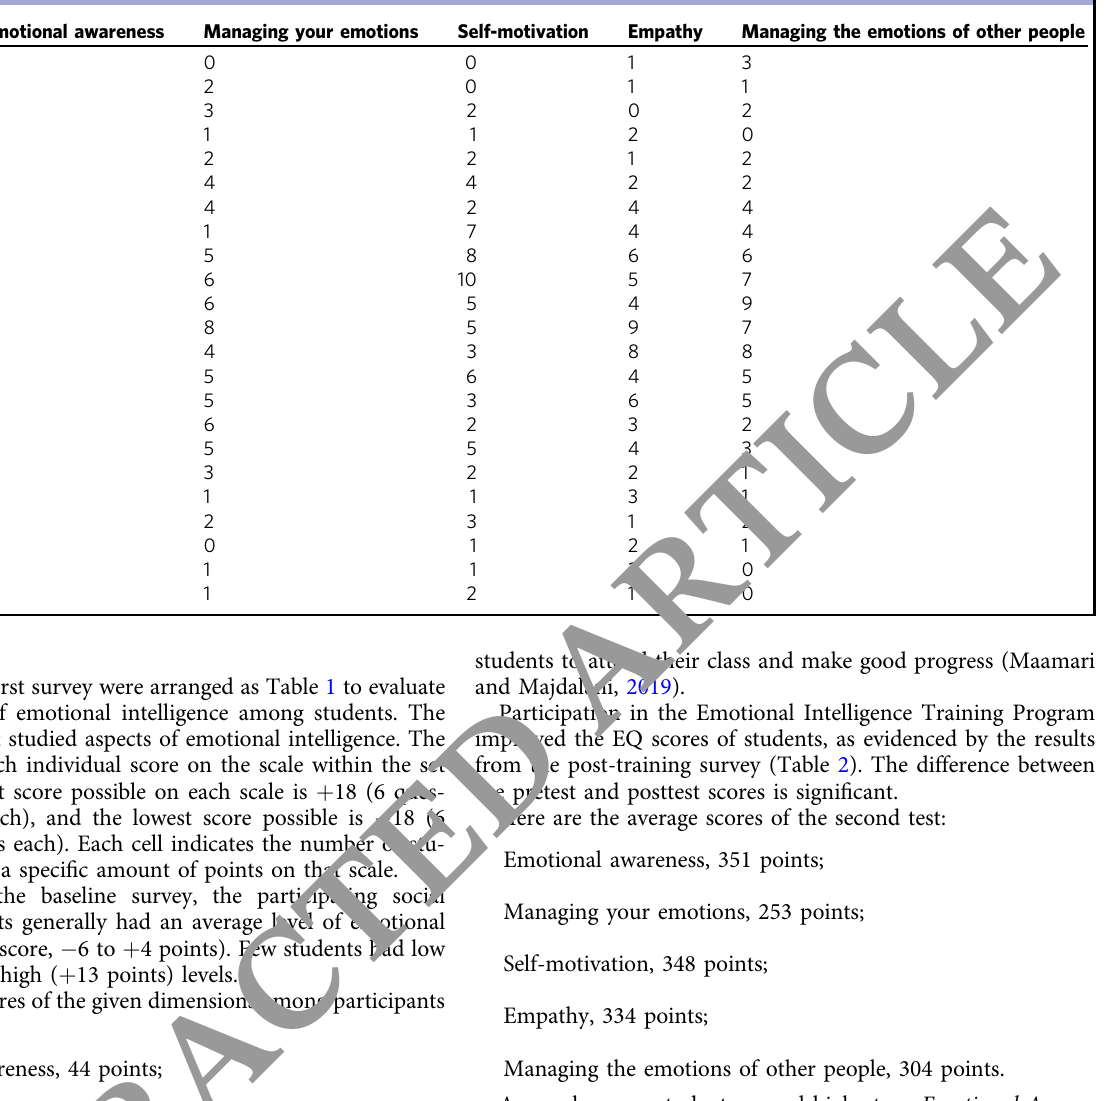
Table 1 EQ test results before